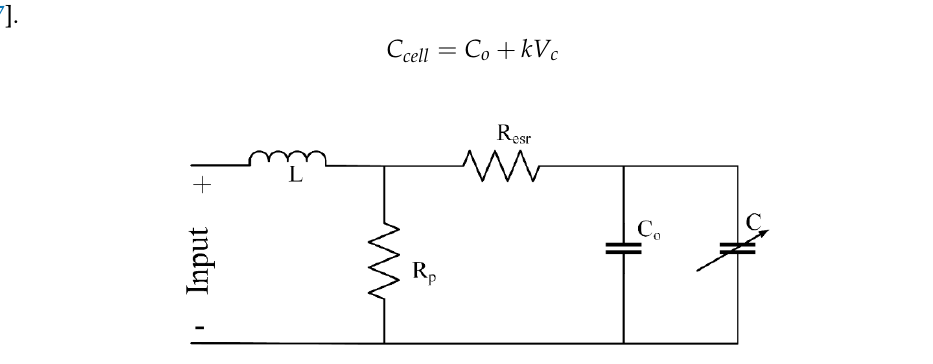
Figure 16. Simplified equivalent circuit of the supercapacitor comprising of two resistors, one inductor, and two capacitors [57].